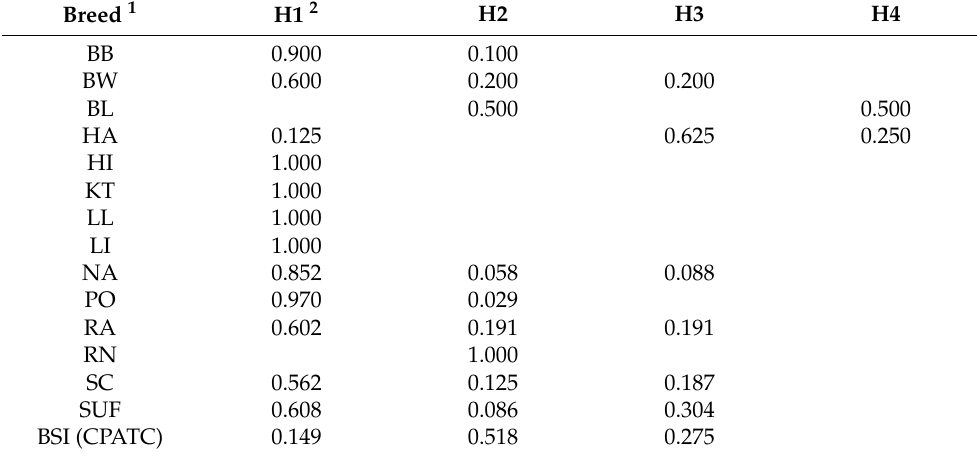
Table 3. TMEM154 haplotype frequencies of North American breeds and Brazilian Santa In ê s generated by 6 SNPs with the KASP